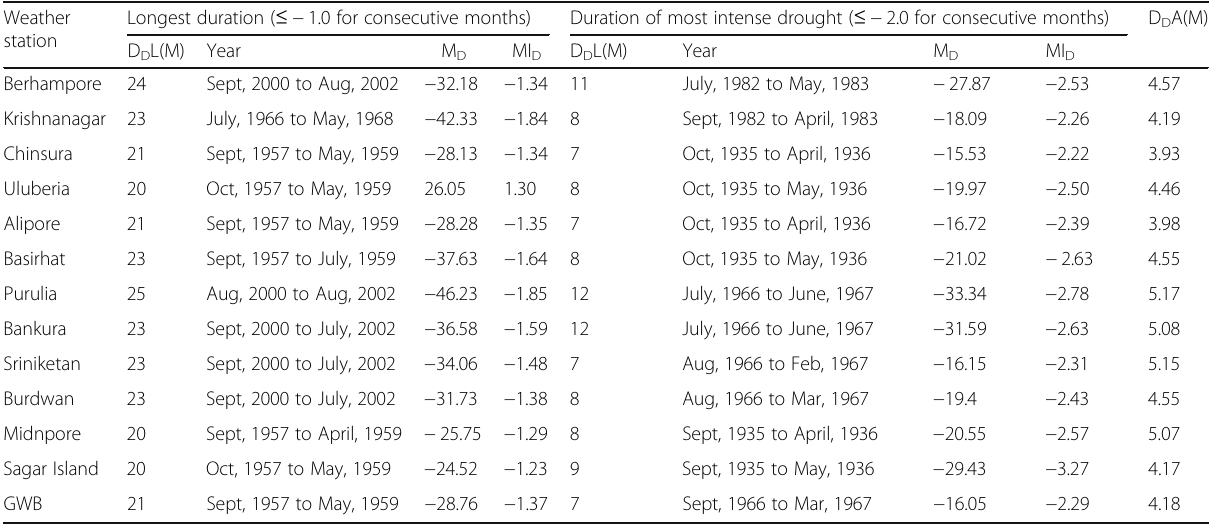
Table 5 Drought duration and magnitude at 12-month time scale for different weather stations of the GWB Weather Longest duration ( ≤ − 1.0 for consecutive months) Duration of most intense drought ( ≤ − 2.0 for consecutive months) station